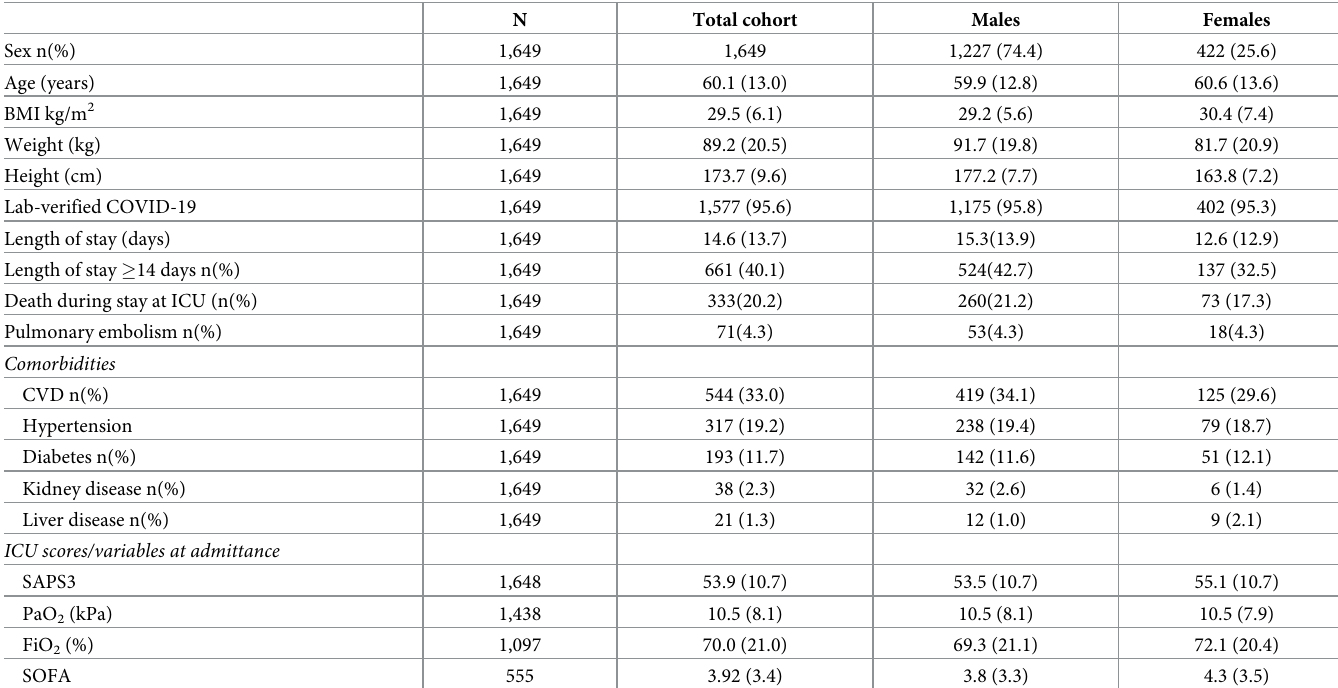
Table 1. Cohort description.